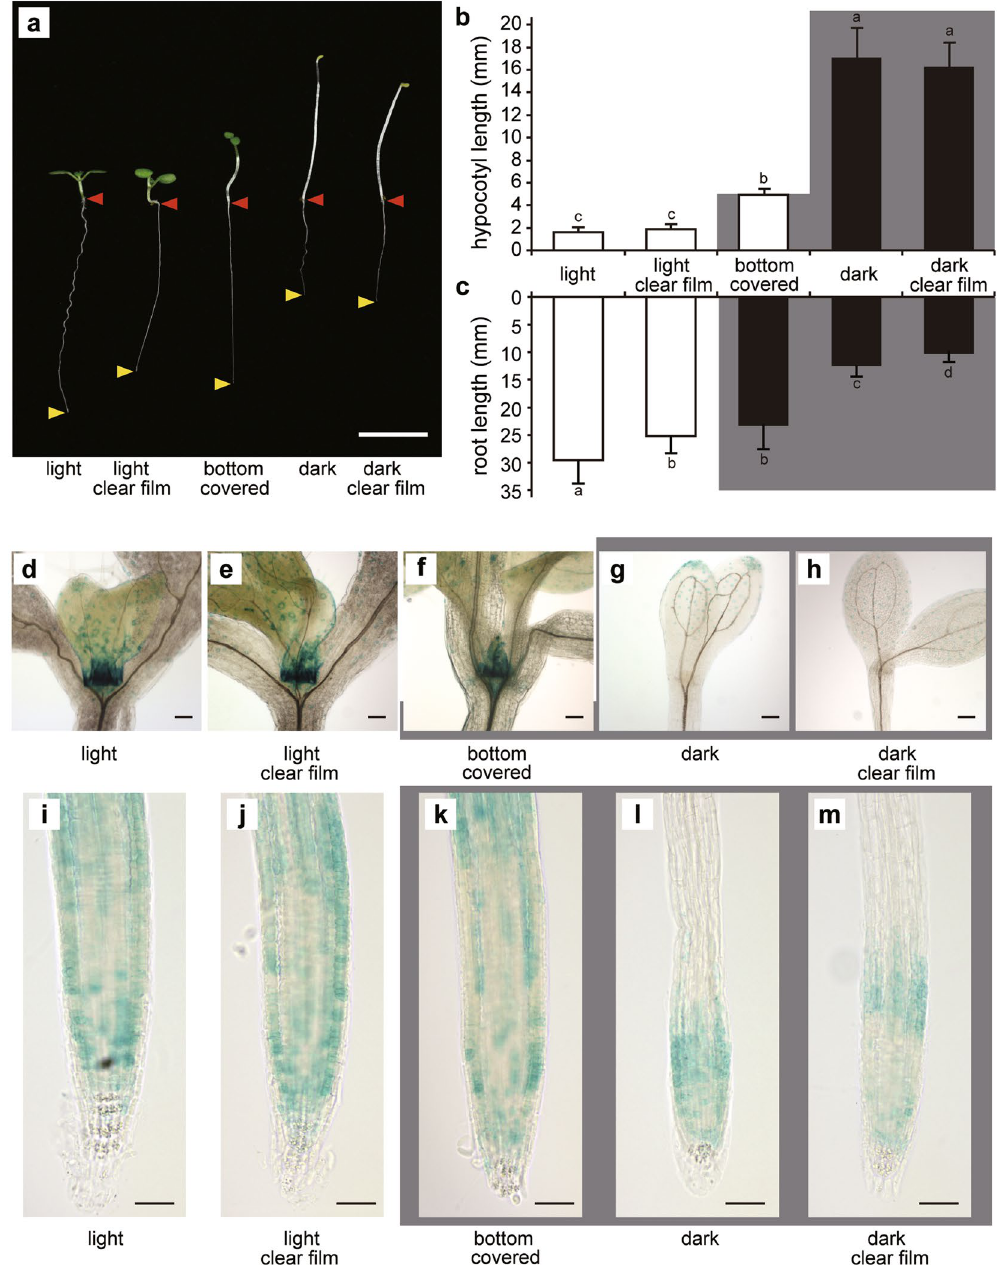
Figure 4. Root elongation and DWF4-GUS expression under light and in darkness according to the bottom half covered growth (BCG) test. The results of the BCG test revealed that light perception in shoots promotes DWF4 expression in the root apex. ( a ) Root elongation. Red arrowheads indicate the junctions between the hypocotyl and root, while yellow arrowheads indicate the root apex positions. Hypocotyl ( b ) and root ( c ) lengths according to the BCG test. The grey background indicates which part was darkened (n = 32). Means denoted by the same letter are not significantly different (P < 0.05) according to the Tukey–Kramer method. DWF4-GUS expression around the shoot apical meristem ( d – h ) and in the root apex ( i – m ). Light conditions with no film ( d , i ) or with a clear film ( e , j ). Shoots under light and roots in darkness covered with a black film ( f , k ). Although the root apex was shaded, the GUS signals in the root meristem were stronger than those of plants maintained in darkness. Dark conditions with no film ( g , l ) or with a clear film ( h , m ). Bars represent 10 mm ( a ) and 50 µ m ( d – m ). Error bars represent standard